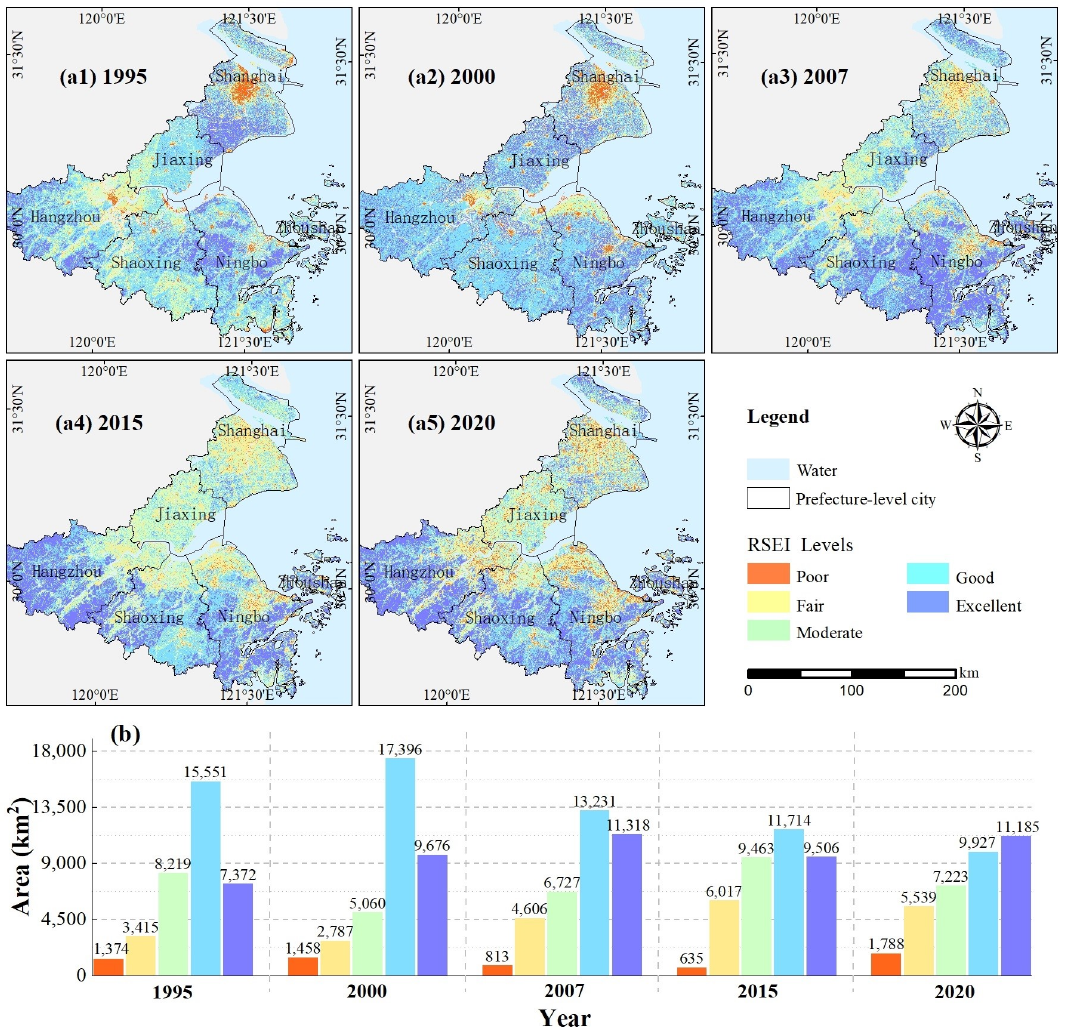
Figure 6. Spatial distribution of RSEI in the HGBA during 1995–2020: ( a1 – a5 ) spatial distribution of the RSEI in 1995, 2000, 2007, 2015, and 2020, respectively; ( b ) area statistics for the grading RSEI (Poor: 0–0.2, Fair: 0.2–0.4, Moderate: 0.4–0.6, Good: 0.6–0.8, and Excellent: 0.8–1.0).